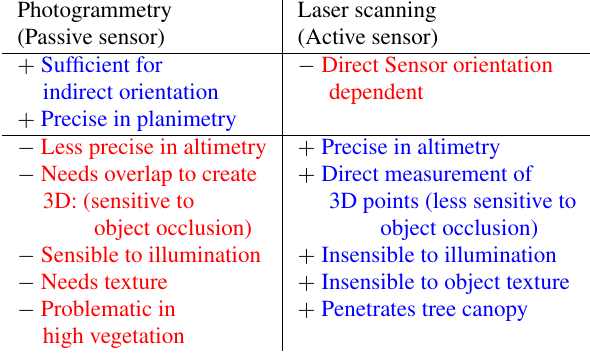
Table 1. Comparison